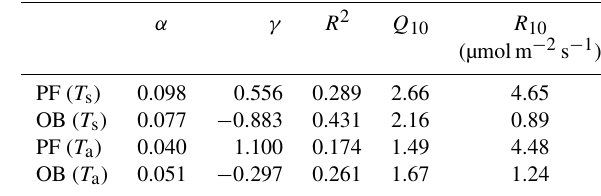
Table 5. Parameters α and γ of Eq. (2) and R 2 ( p < 0 . 01) and Q 10 and R 10 coefficients calculated using soil ( T s ) and air ( T a ) temperature at the paludified forest (PF) and ombrotrophic bog sites